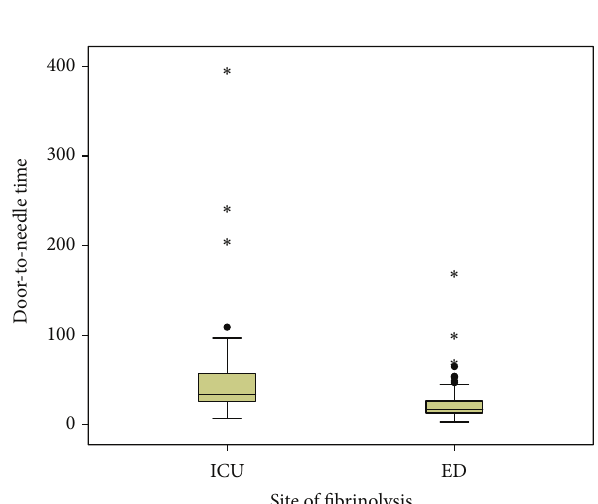
Figure 2: Flow chart of patient allocation.